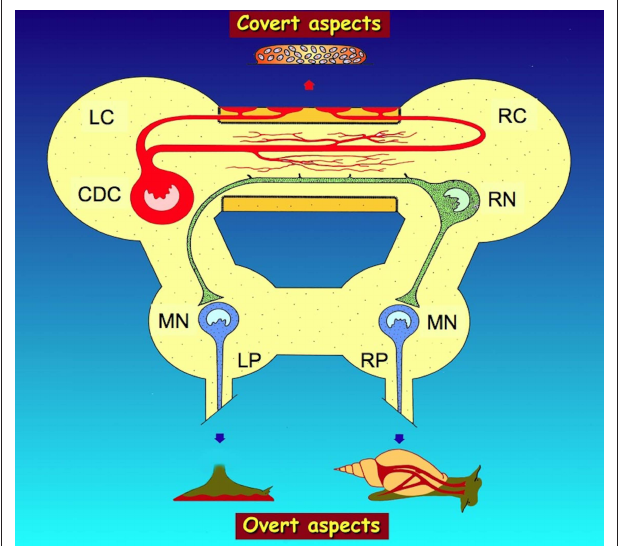
FigurE 1 | Summarizing scheme of the regulation by the caudodorsal cells (CDC) of Lymnaea stagnalis of overt (visible) and covert (invisible) aspects of egg-laying behavior by, respectively, neurohemal peptide release from axon terminals in the periphery of the cerebral commissure and non-synaptic peptide release from axon collaterals in the inner part of the commissure. Overt aspects include the activation of muscles in the foot for locomotion during substrate cleaning ( bottom left ) and of muscles attached to the shell for shell turning ( bottom right ), while covert aspects include the induction of ovulation and the activation of accessory sex glands to produce an egg mass ( top ). For details on these aspects, see text. LC, left cerebral ganglion; LP, left pedal ganglion; MN, motor neurons; RC, right cerebral ganglion; RN, Ring neuron; RP, right pedal